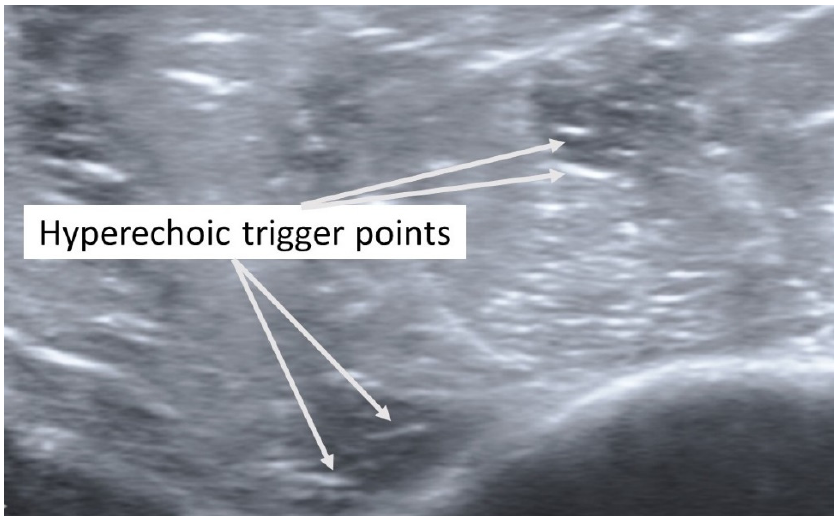
Figure 3. Ultrasound imaging assessment of the right deltoid muscle showing two palpable contrac- ture knots as hypoechoic (hyperperfused) areas.